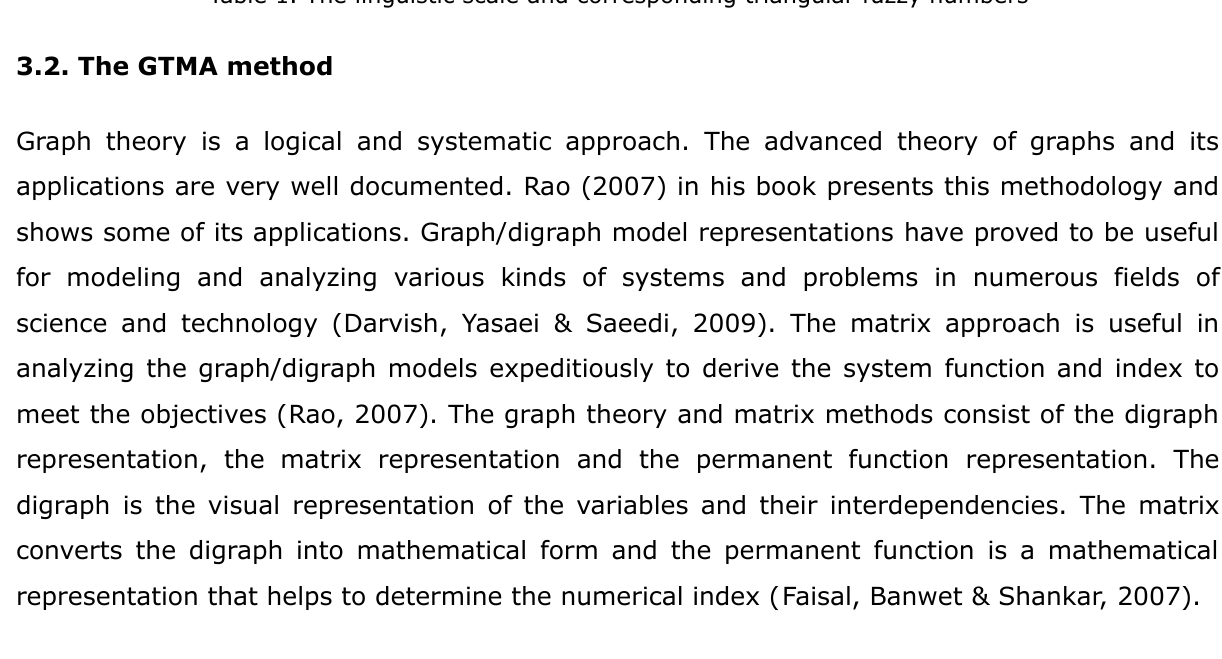
Table 1. The linguistic scale and corresponding triangular fuzzy